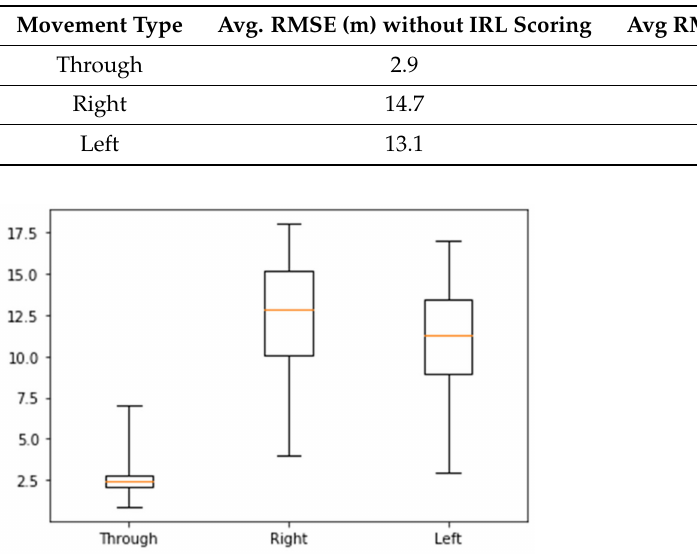
Table 5. RMSE values by movement type.